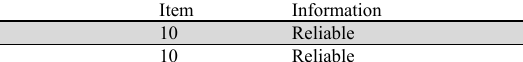
Reliability test